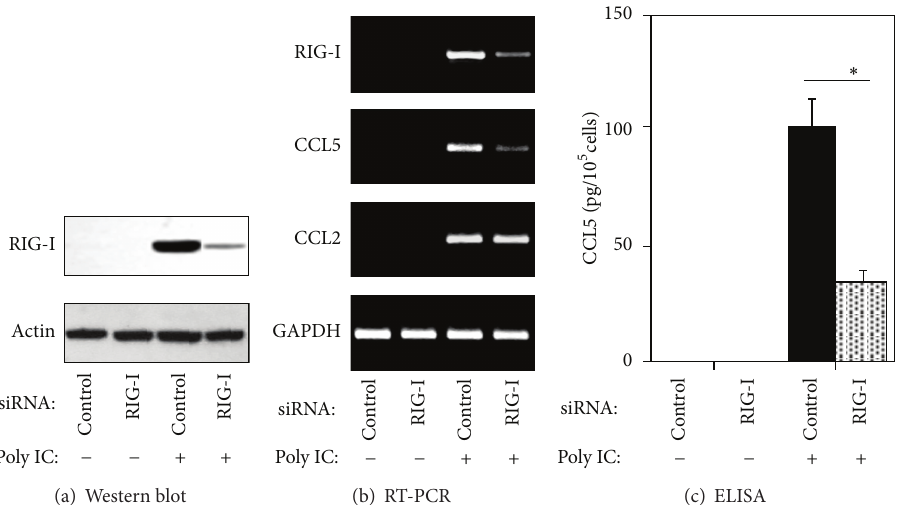
Figure1:KnockdownofRIG-IreducesthepolyIC-inducedexpressionofCCL5inhumanMCs.ThecellsweretransfectedwithsiRNAagainst RIG-I or control siRNA and then stimulated with 20 𝜇 g/mL of poly IC (Imaizumi et al. NDT 2010). (a) After 24h of poly IC treatment, the cells were lysed, and western blotting for CCL5 was performed. (b) The cells were incubated for 16h with poly IC, RNA was extracted, and RT-PCR was performed for RIG-I, CCL5, and CCL2. (c) The culture medium was collected after 24 h, and the concentration of CCL5 was determined by ELISA ( 𝑛 = 3 , ∗ 𝑃 < 0.01